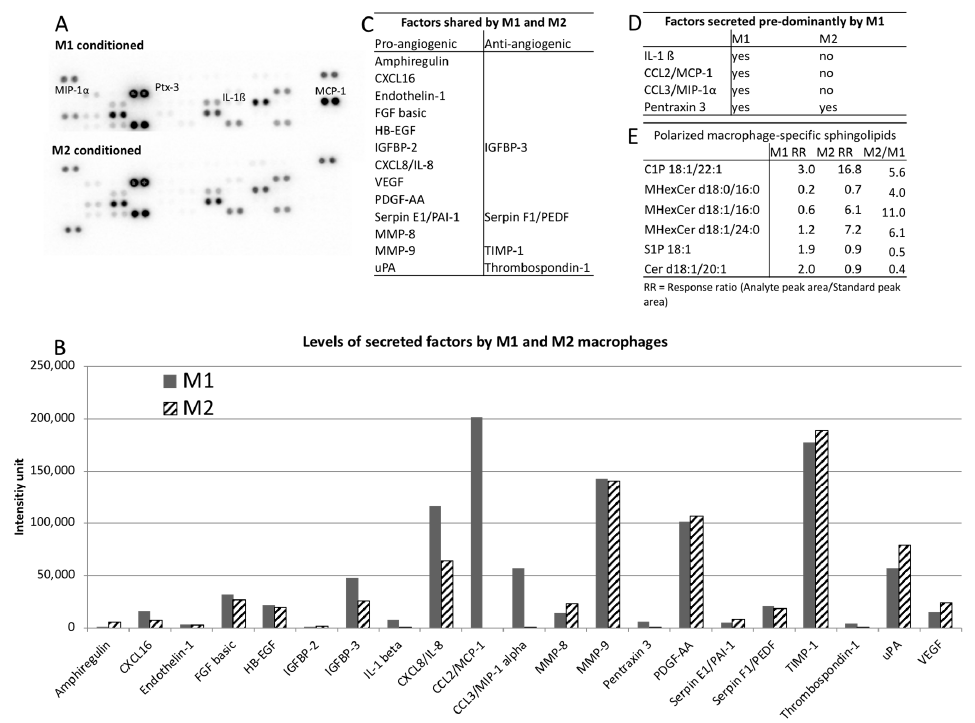
Figure 4. Analysis of macrophage secretome. ( A ) Chemiluminescently developed angiogenesis proteome profiler array membranes incubated with M1 or M2 conditioned media, respectively. ( B ) Signal intensities depicting factors secreted by either M1 or M2 or by both (M1 & M2) as identified proteome profiler array. ( C ) Summary of factors shared by M1 and M2 sorted by their pro- and anti-angiogenic properties. ( D ) Summary of factors secreted solely or predominantly by M1. ( E ) Sphingolipids specific for polarized macrophages as identified by mass spectrometry-based relative quantitation (Sphingolipidomics). Response ratios (RR) were quantified by dividing the analyte peak area/standard peak area. M2/M1 ratio > 2 or < 0.5 with a p < 0.05 were defined as sphingolipids with significant differences between M1 and